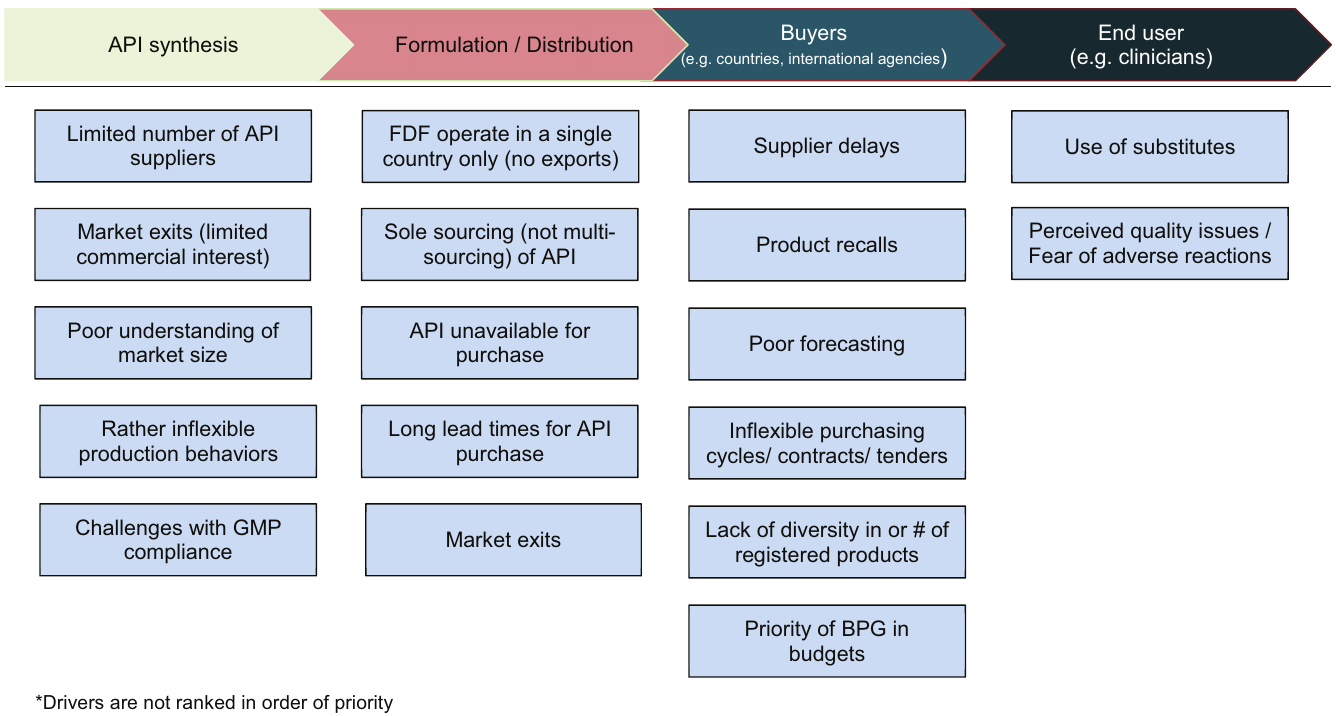
Fig 3. Identified drivers of BPG stock-outs across the value chain. * API, active pharmaceutical ingredient;BPG, benzathine penicillinG; FDF, final dose formulator; GMP, Good Manufacturing Practice.